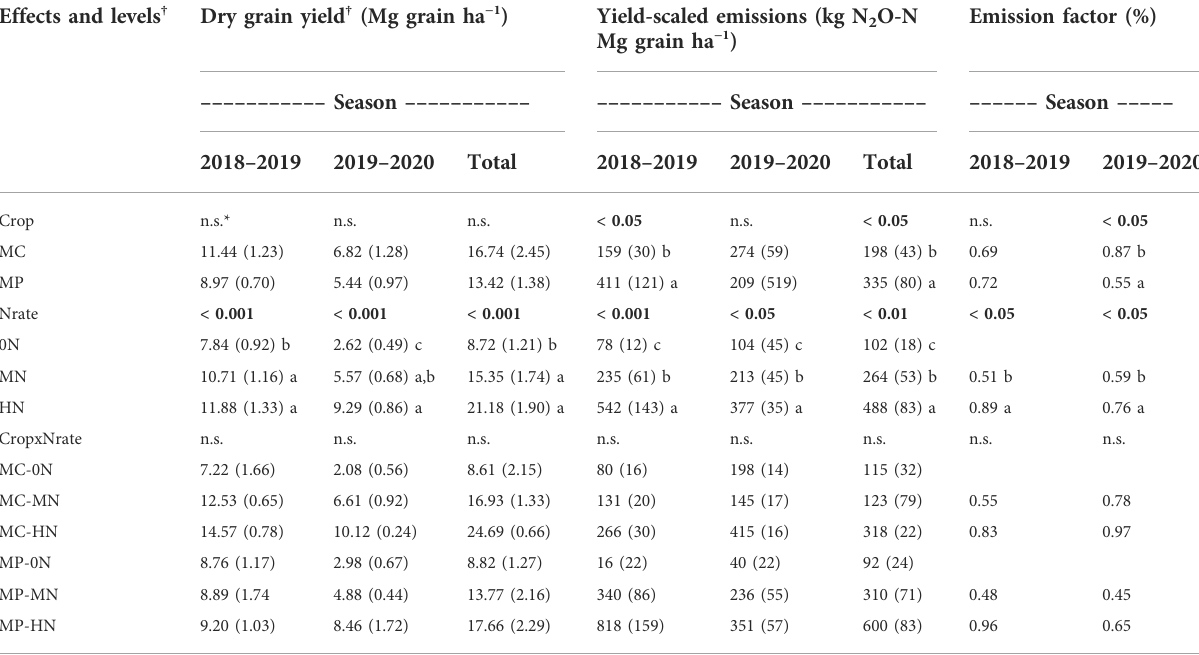
TABLE 4 Dry grain yield, yield-scaled emissions and nitrogen emission factor for the growing season periods of 2018, 2019 and 2019, 2020 and the total experimental period as affected by cropping system (Crop) (maize monoculture, MC; pea maize cropping system, MP), nitrogen application rate (Nrate) (Control, 0N; Medium rate, MN, and High rate, HN) and their interactions. Effects and levels